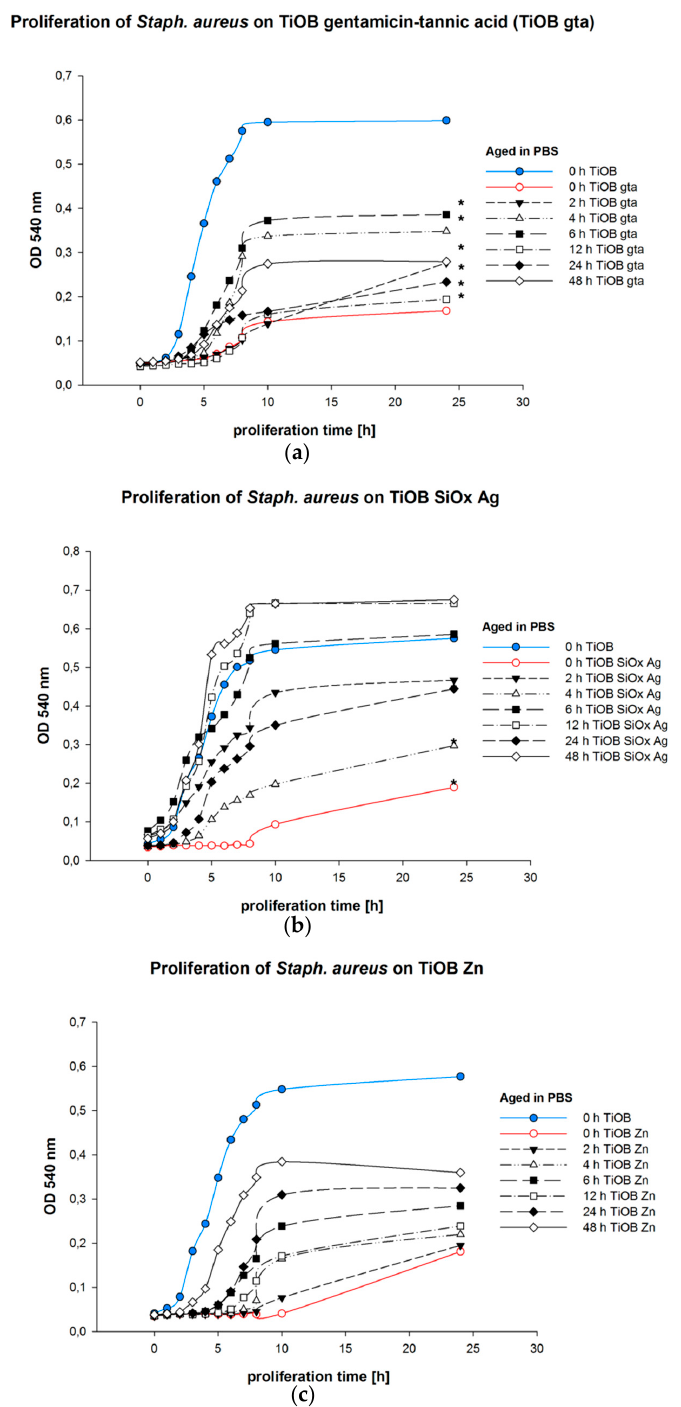
Figure 4. Proliferation of Staphylococcus aureus on functionalized TiOB ® : ( a ) TiOB ® gta; ( b ) TiOB ® SiOx Ag; ( c ) TiOB ® Zn. Samples were pre-incubated (aged) in PBS for 0, 2, 4, 6, 12, 24, and 48 h. Non-functionalized TiOB ® (TiOB ® control) is presented as a blue graph. Non-aged but antibacterial functionalized samples are shown in red. Significances to non-functionalized TiOB ® are marked by stars ( p <